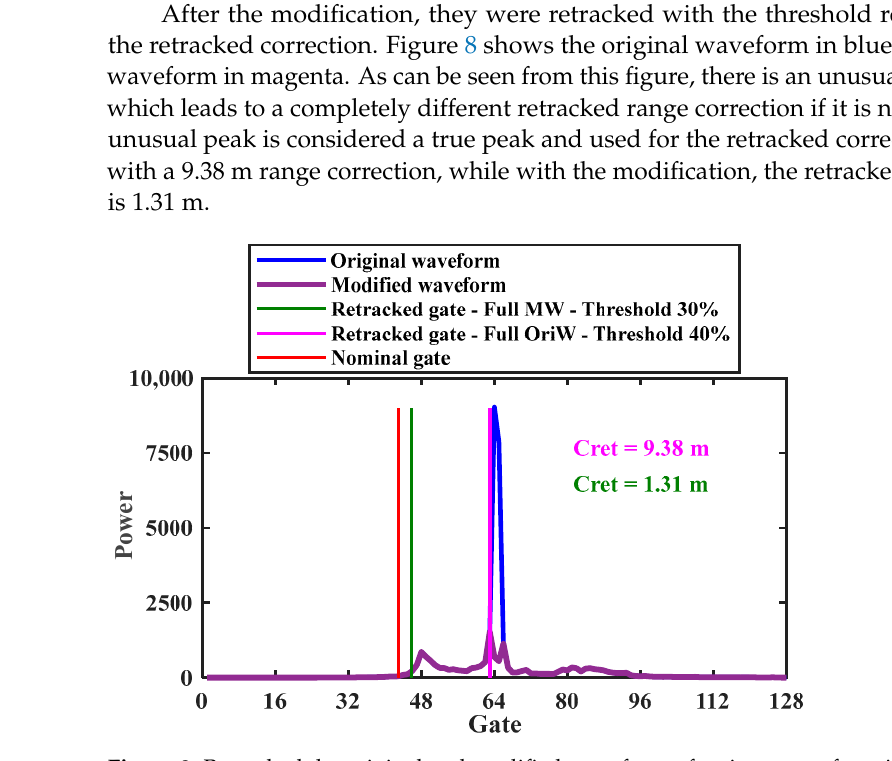
Figure 8. Retracked the original and modified waveform of a given waveform in pass 25 cycle 44 in the Persian Gulf.